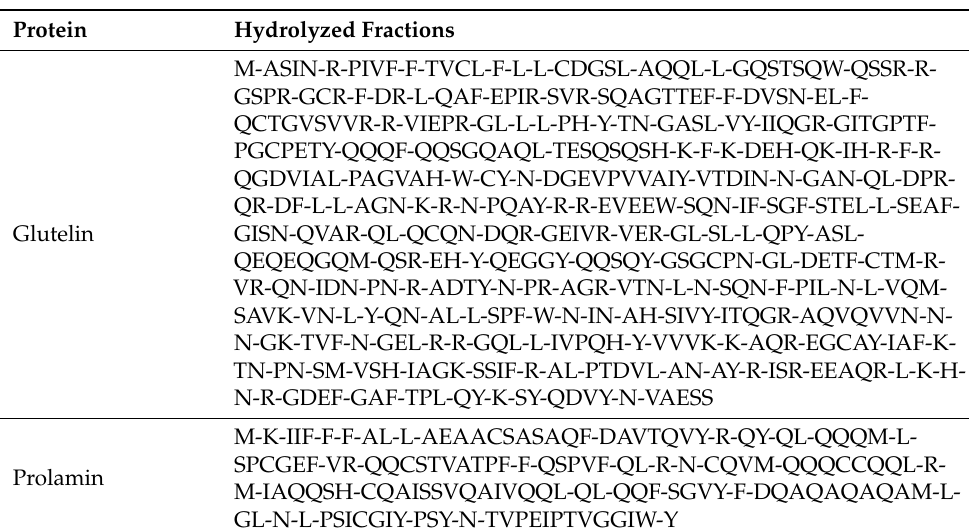
Table 5. Protein fractions released after proteolysis.